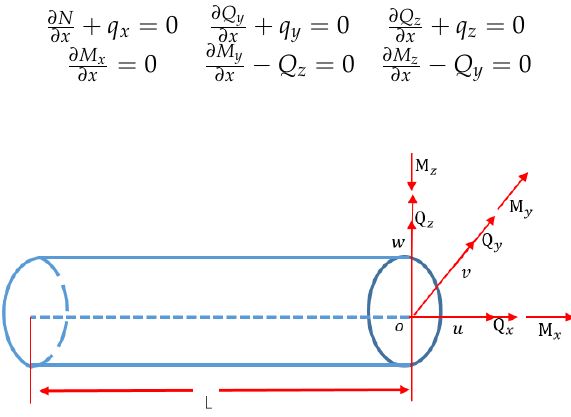
Figure 5. Beam section forces and moments [18].